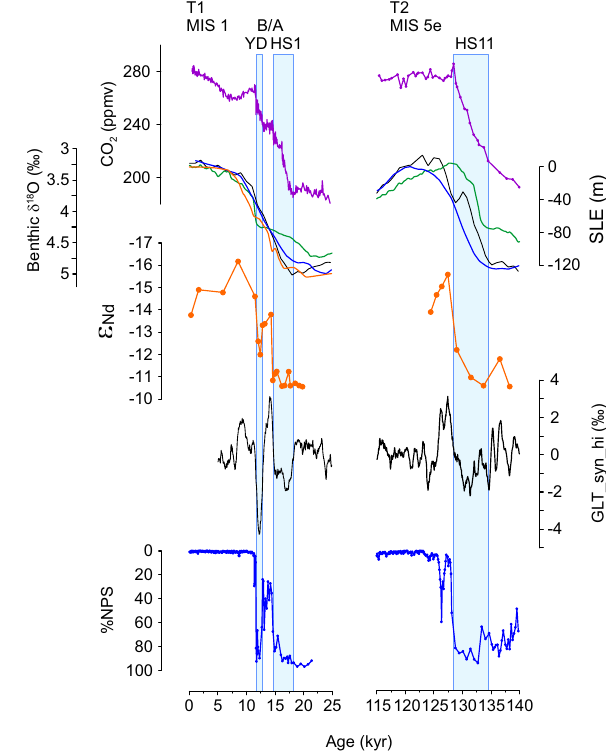
Fig. 4 The last two terminations. From top to bottom: Deglacial timeseries of atmospheric CO 2 31,97 , benthic δ 18 O (black curve 65 ) and sea level reconstructions (orange 100 ; green 92 ; blue 93 ), NW Atlantic sedimentary ε Nd 21,23 (sensitive to ocean circulation change), GL 27 (a low order T _syn_hi approximation of AMOC strength 25 ) and %NPS (a temperature proxy) from the NE Atlantic 68 . Blue boxes are cold (weak AMOC) intervals. T1, T2 are Terminations 1 and 2; MIS 1, MIS 5e are Marine Isotope Stages; B/A Bølling/Allerød, YD Younger Dryas, HS1, HS11 are Heinrich Stadials, within which Heinrich events, HE1 and HE11 occurred. SLE is Sea Level Equivalent.